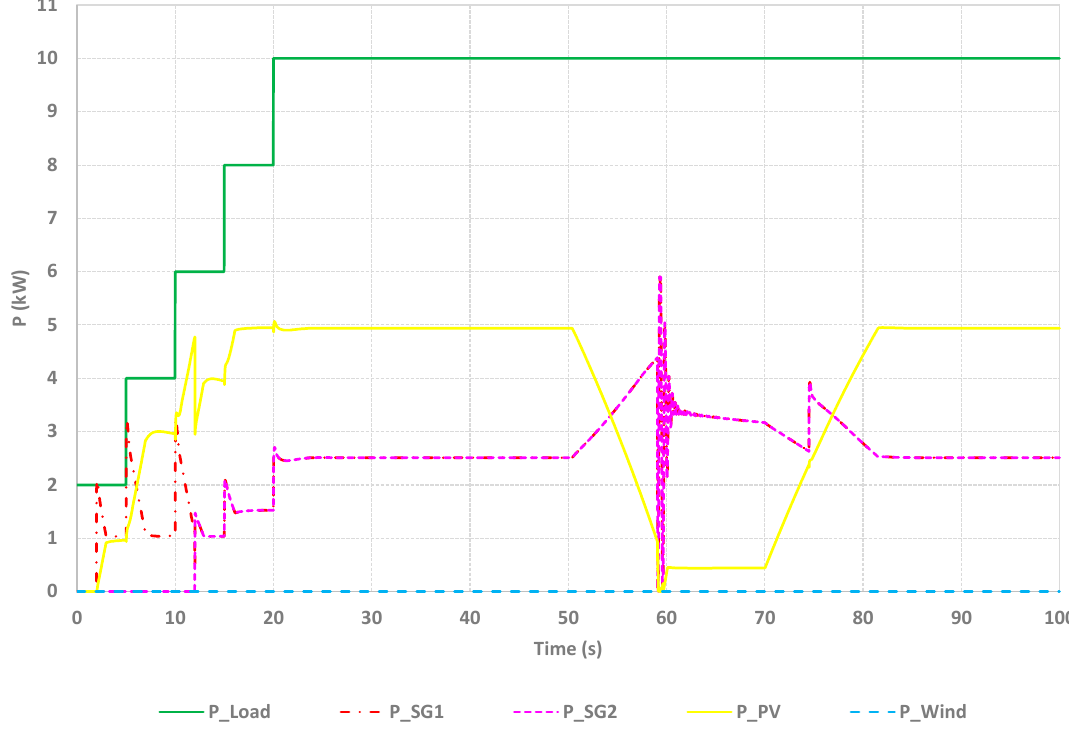
Figure 10. Scenario 4b: Cloud transient analysis for maximum solar PV generation and zero wind generation for a 10 kW demand.